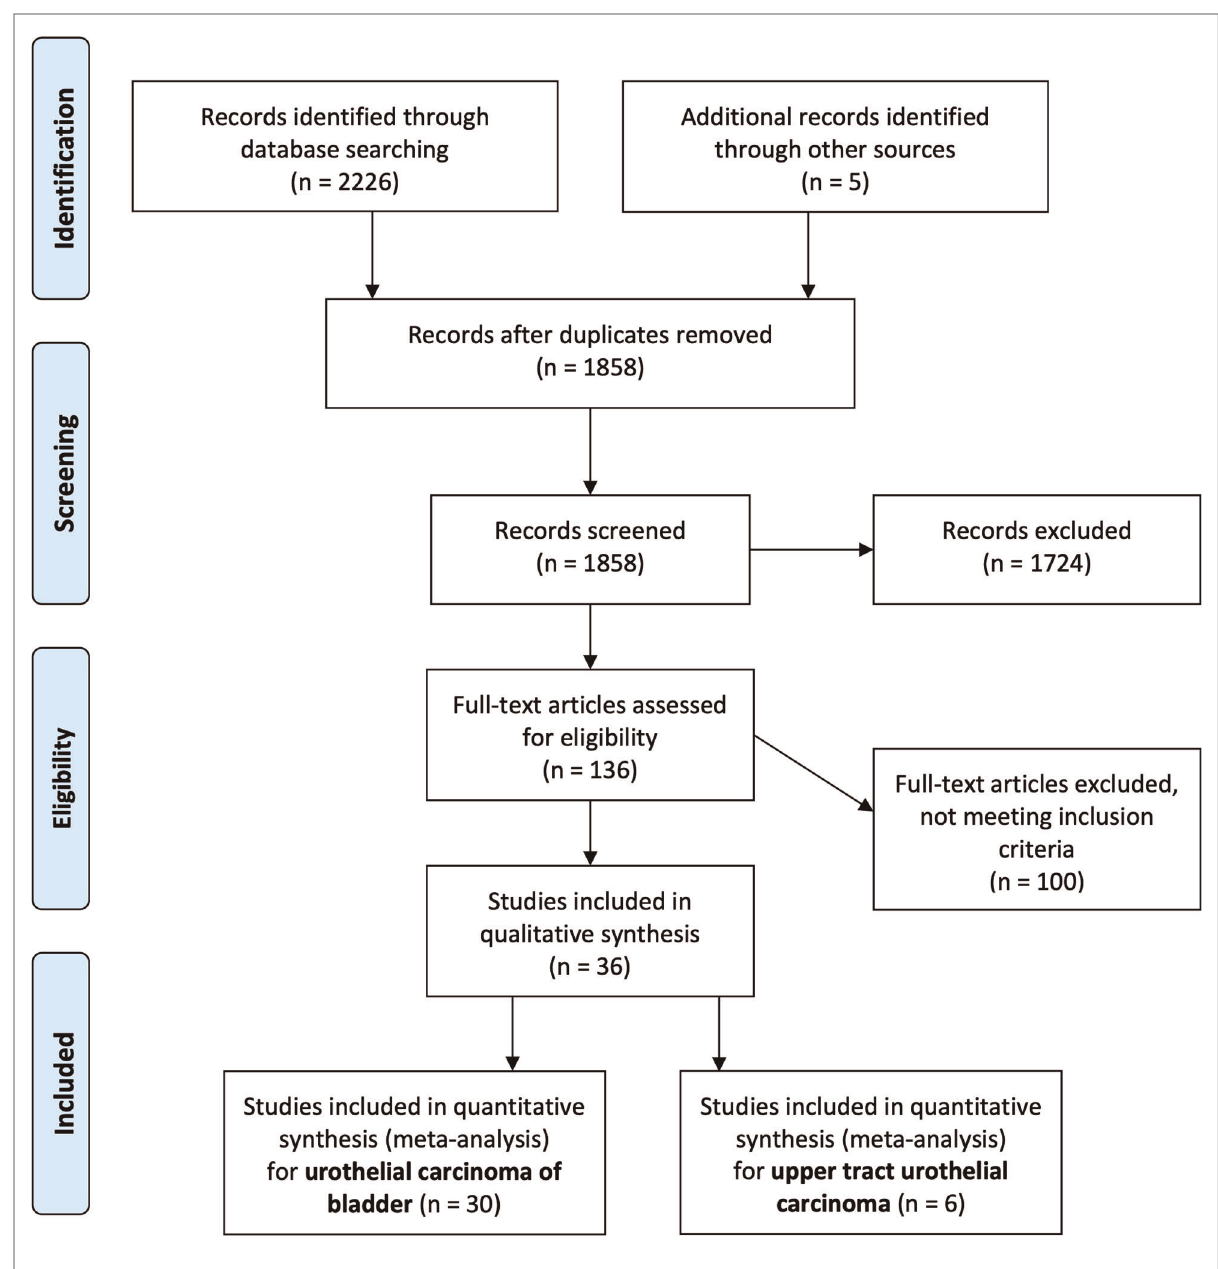
FIGURE 1 PRISMA fl ow